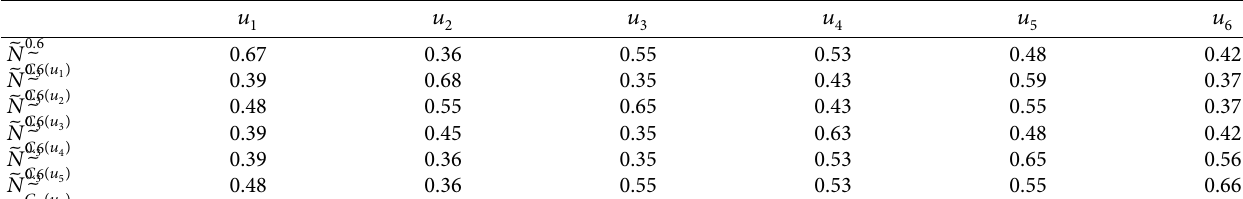
Table 17: Table for 􏽥 M 0 . 6 􏽥